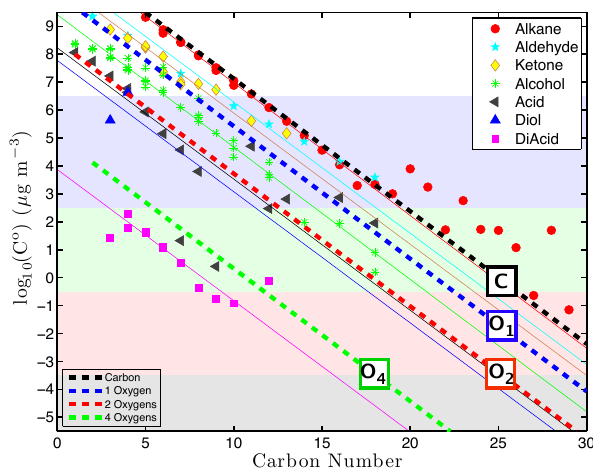
Carbon Number Fig. 1. Volatility (log 10 ( C o /µgm − 3 ) ) vs. carbon number ( n C ) for different classes of organic compounds (indicated with colored symbols). Each class contains the same oxygen functionality but a range of n C . The slopes of the class lines show the effect of increas- ing n C ( − 0.475 decades per C), while offsets from the hydrocarbon line show the effects of functionalization. Carbonyls decrease C o by about 1 decade per (=O) while alcohols decrease C o by about 2.3 decades per (-OH). The average is − 1 . 7 decades per O, indi- cated with dashed lines for 0, 1, 2, and 4